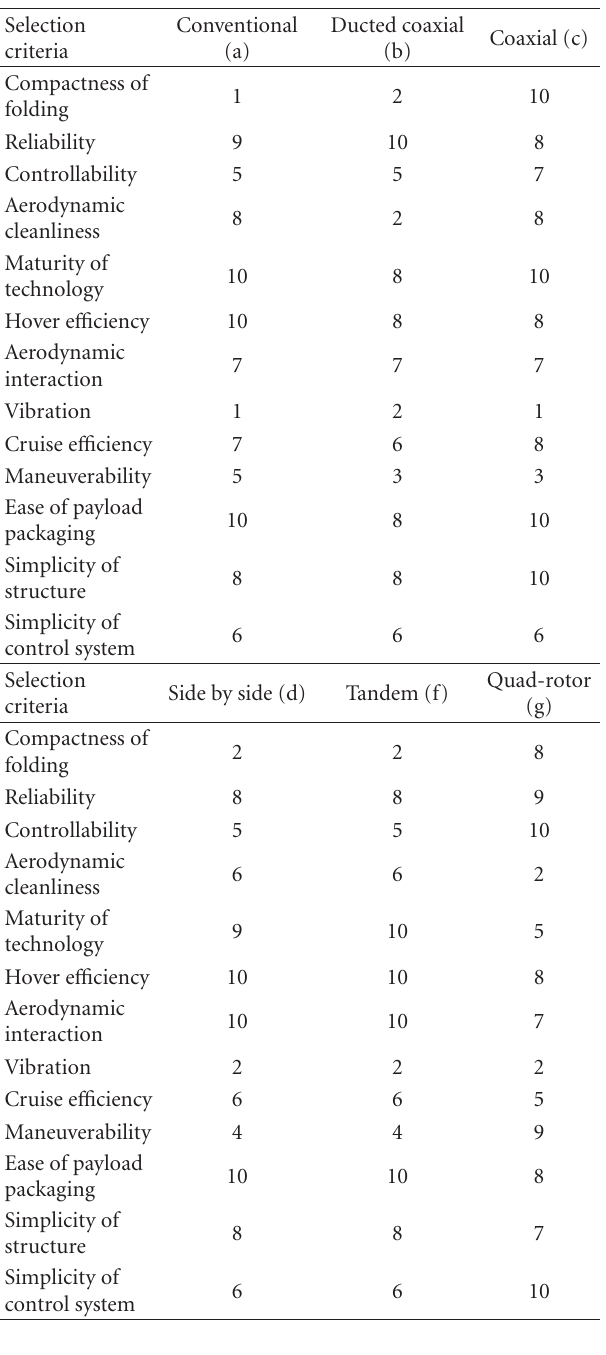
Table 2: Selection criteria of di ff erent rotary AVS typologies [27] (1: bad, 10: very